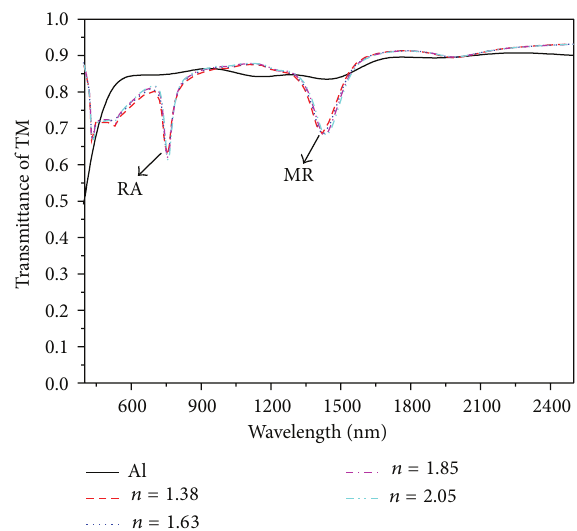
Figure 4: Calculated relationship between refractive index of middle layer and the transmittance of TM.